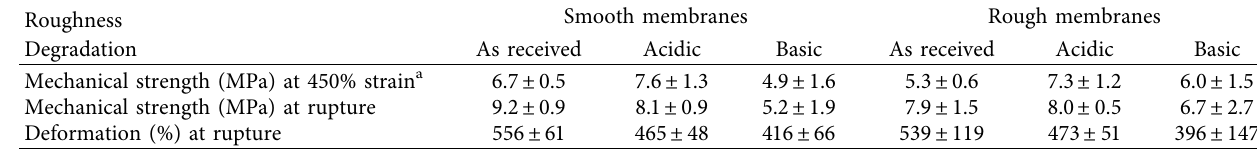
Table 3: Mechanical properties for samples as received and after acidic and basic degradation. Roughness